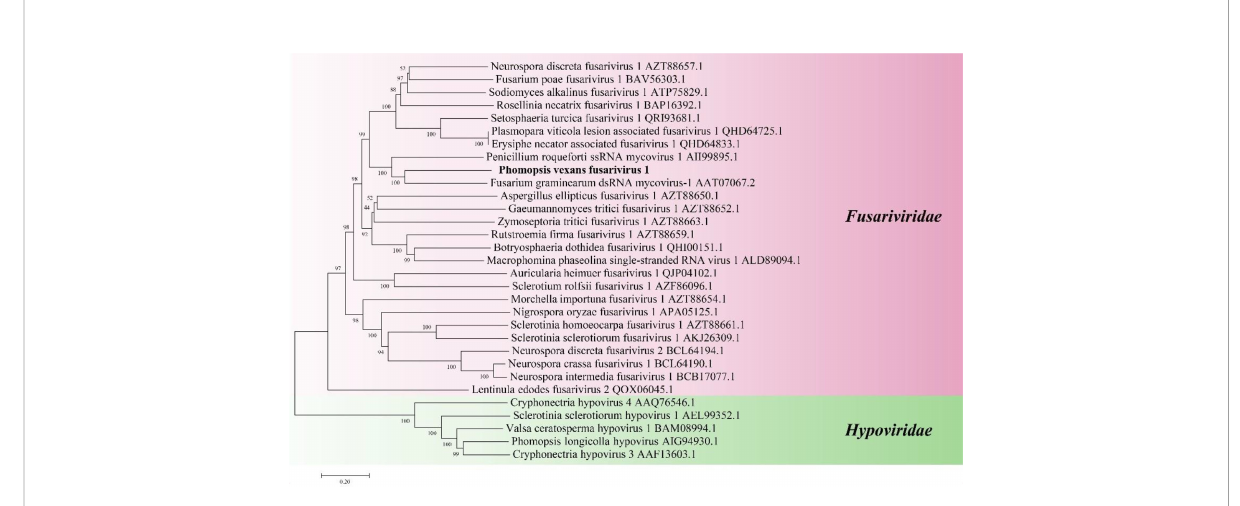
FIGURE 9 Phylogenetic analysis of PvFV1. Phylogenetic analysis illustrating the evolutionary classi fi cation of PvFV1 was conducted using the method described in Figure 7. The scale bar represents a genetic distance of 0.2 aa substitutions per site. The black bold font indicates the novel mycoviruses PvFV1 identi fi ed in the present study. The names and database accession numbers of other related viruses analyzed are indicated in the